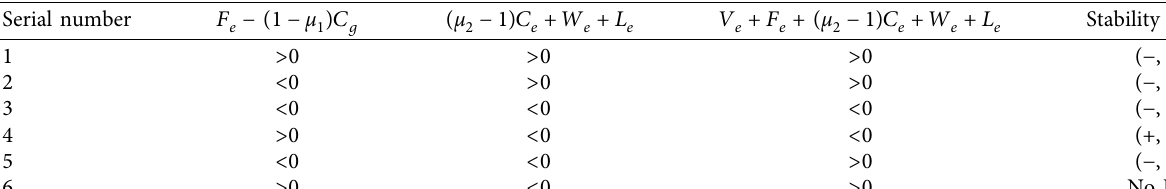
Table 9: Government and enterprise strategy choices.